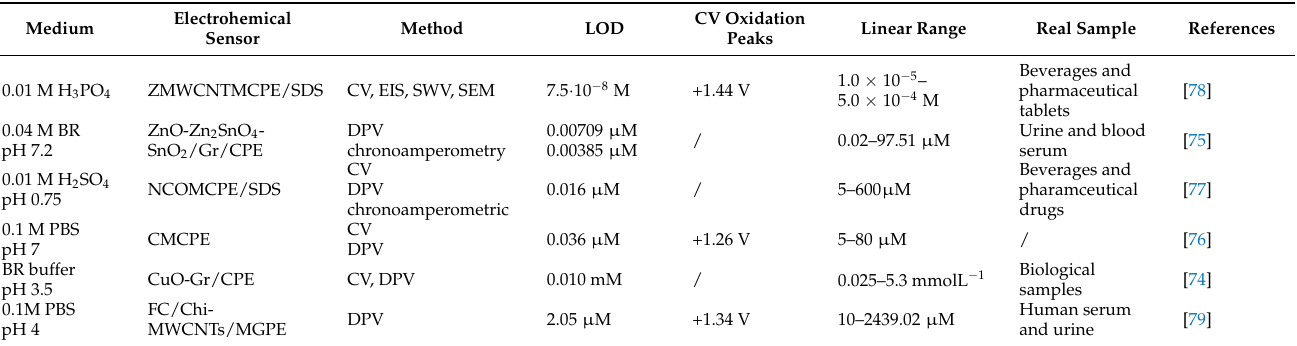
Table 2. Electrochemical characteristics of carbon paste electrode as sensor for caffeine determination.